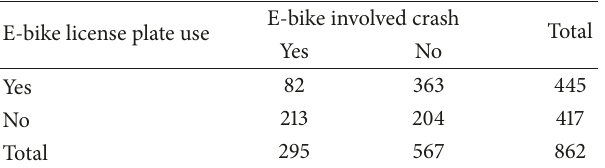
Table 1: Cross-tabulation by e-bike involved crash and e-bike license plate